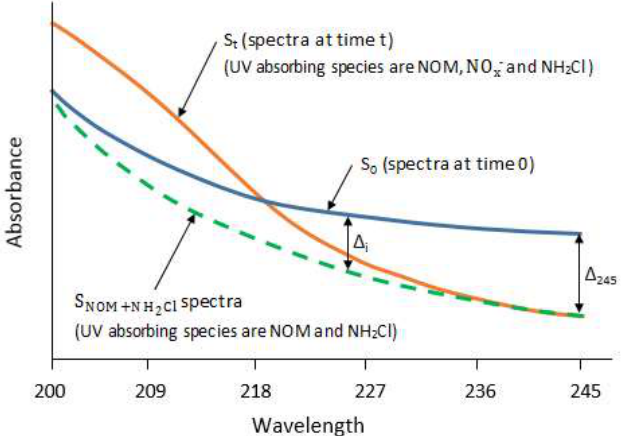
Figure 3. Procedure of estimating the spectra at time t subjected to monochloramine decay